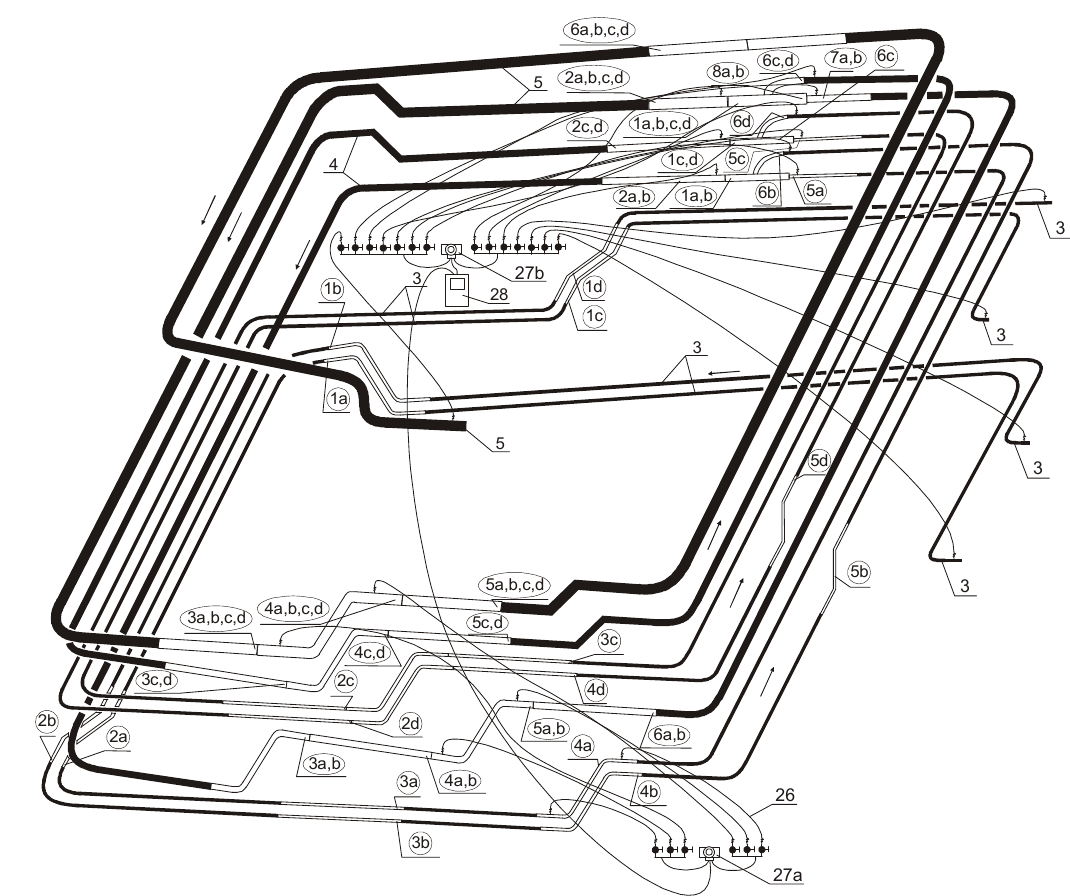
Figure 4. Vacuum pipelines acc. Figure 2: 3-vacuum pipeline with diameter of 57 mm; 4-vacuum pipeline with diameter of 81 mm; 5-vacuum pipeline with diameter of 102 mm; 26-impulse hose, 1a-6d-stand for observation of flow structures; 27a,b-electronic meter of pres-sure difference; 28-register of measurement results.